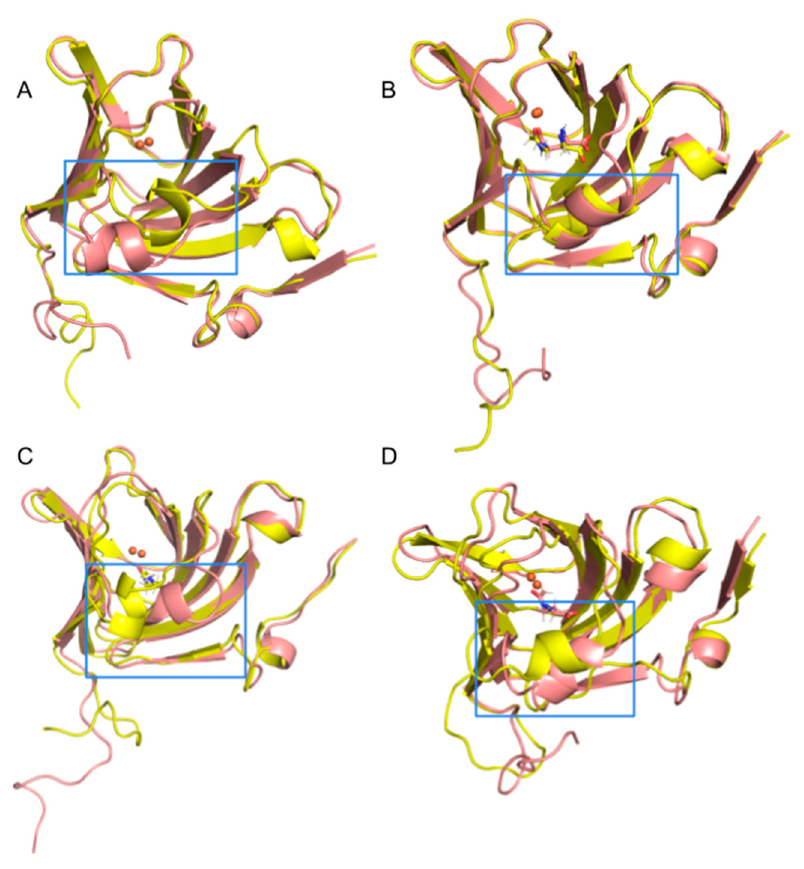
Figure 7. Alignment of monomer centroids (all in the holo form with Fe 2+ ) from: ( A ) MD in which both monomers are empty; ( B ) MD in which both monomers are occupied by the substrate; ( C , D ) MD in which one monomer is in complex with the substrate (monomer 1 in ( C ); monomer 2 in ( D )) while the other is empty. Monomer 1 is in yellow, monomer 2 is in pink. Blue frames embrace the α -II helix. Table 1. The RMSF values calculated for the α -II helix in: MDs for models with one monomer empty (E) and another one occupied (O) in dimers partially occupied (EO/OE, Figure S7C,D) (orange colour); and MDs for models with EctC monomers both occupied (OO, Figure S7B) or both empty (EE, Figure S7A) (purple colour).